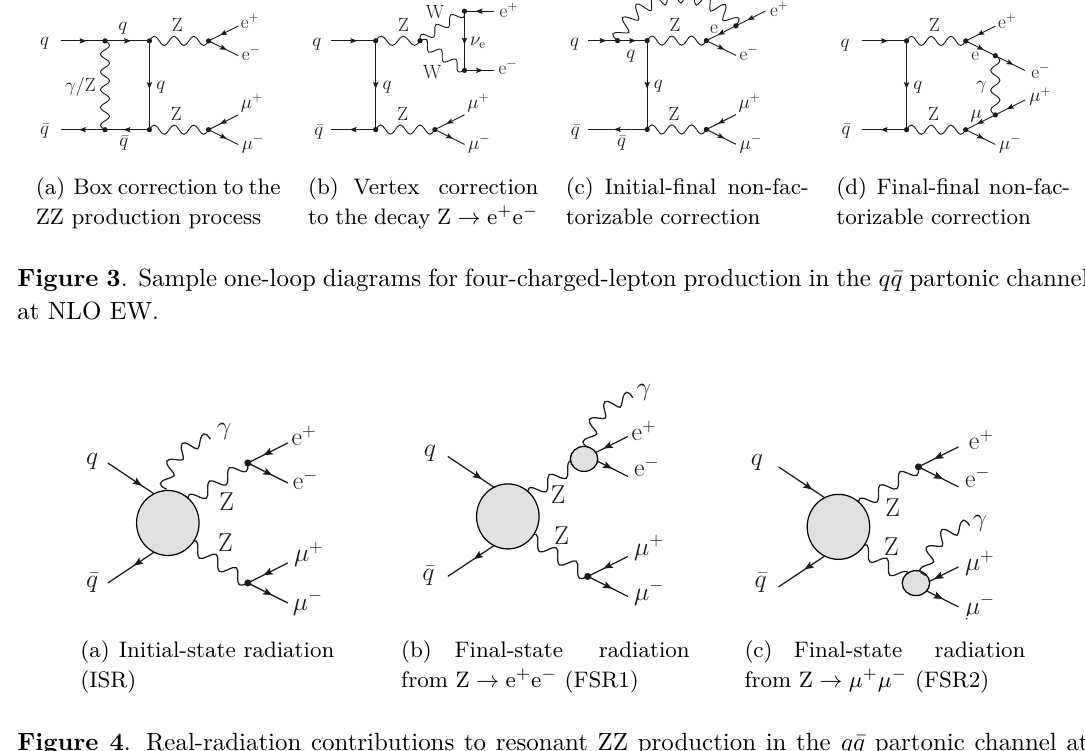
Figure 4 . Real-radiation contributions to resonant ZZ production in the q ¯ q partonic channel at NLO